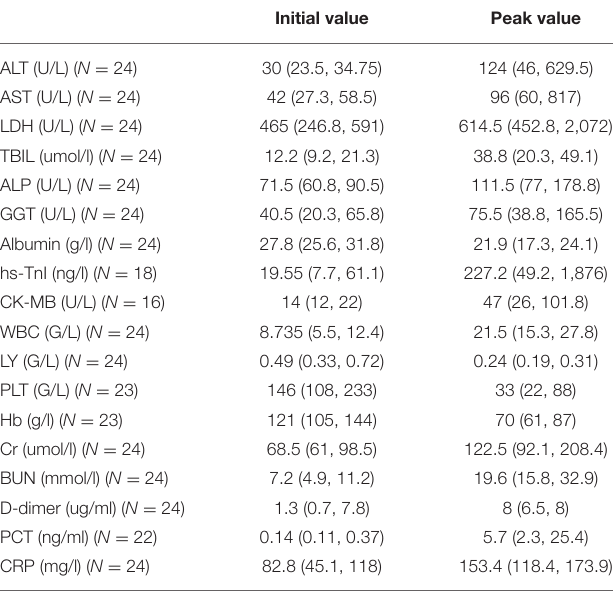
TABLE 2 | Summary of laboratory results.